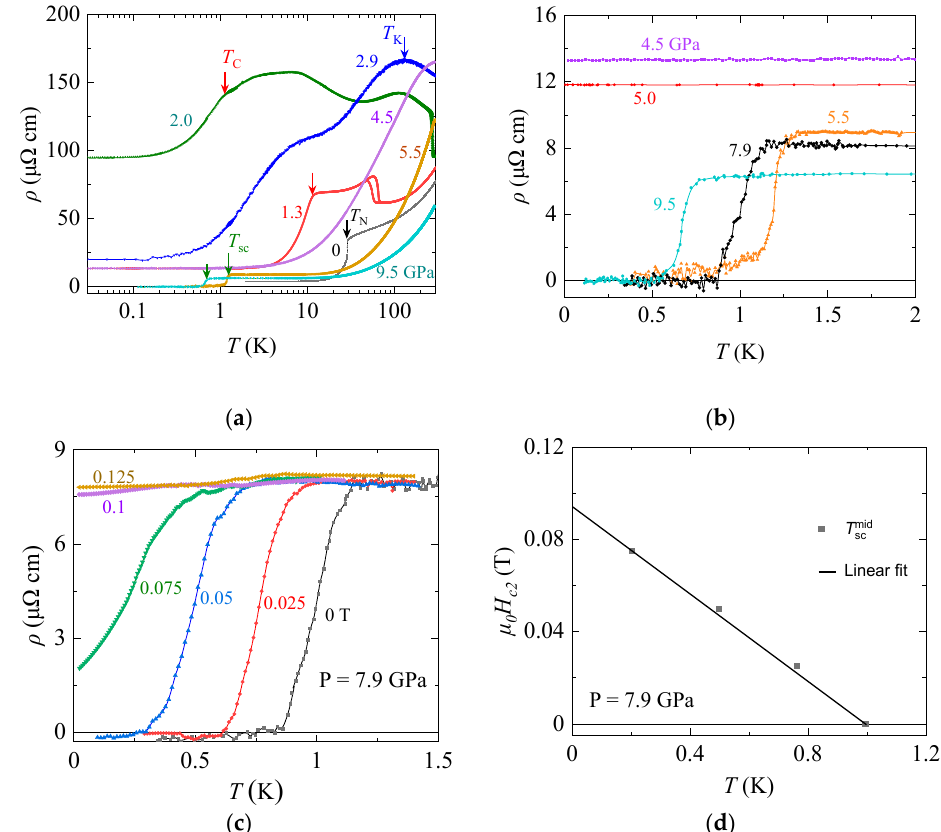
Figure 1. ( a ) Temperature dependence of electrical resistivity ρ , of CeZn single crystal at some selected pressures. Black and red arrows show the magnetic transition temperatures, T N and T C , respectively. Blue arrow indicates Kondo temperature ( T K ), and green arrows indicate superconductivity transition temperature ( T sc ); ( b ) A zoomed-in view of the low temperature ρ ( T ) for pressure above 4.5 GPa displaying the superconducting transitions. ( c ) ρ ( T ) near the superconducting transition under different applied magnetic fields at 7.9 GPa. ( d ) Temperature dependence of upper critical field µ 0 H c 2 estimated from the T mid sc as described in the main